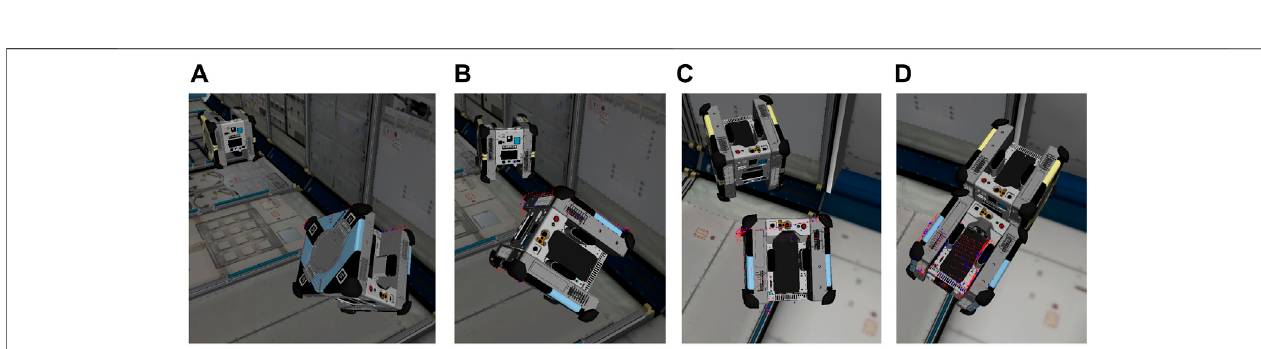
FIGURE14| Atimelapse oftherendezvousportionofthepipelineforanarbitrarytri-axialtumble. (A – D) ,theChaserbegins trackingthemotion planwithitsrobust controller while periodically updating the inertial frame reference trajectory based on SLAM estimates of (cid:14) q T . Figure 4 . The primary ingredients remaining before robust tube MPC can begin tracking are an approximation of the robust invariant set (RPI), Z and accompanying tightened input and state constraints, and real-time updates of the estimated Target ( i ). orientation (cid:14) q T